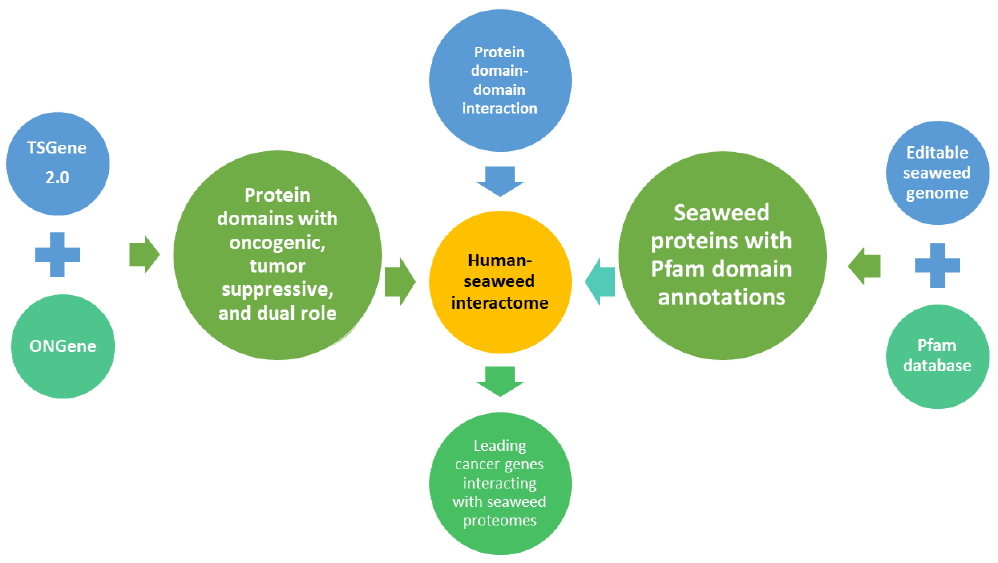
Figure 1. A computational workflow to construct a putative interactome between cancer-related and seaweed proteins based on known interactions between functional protein domains. Specifically, cancer-related genes in this study refer to known tumour suppressor genes and oncogenes. The seaweed protein sequences were derived from 12 seaweed genomes. We then annotated all human cancer genes and edible seaweed proteins through the hidden Markov modes profile of the Pfam database. Finally, potential links between seaweed and cancer proteins were built through the functional domain – domain interactions.